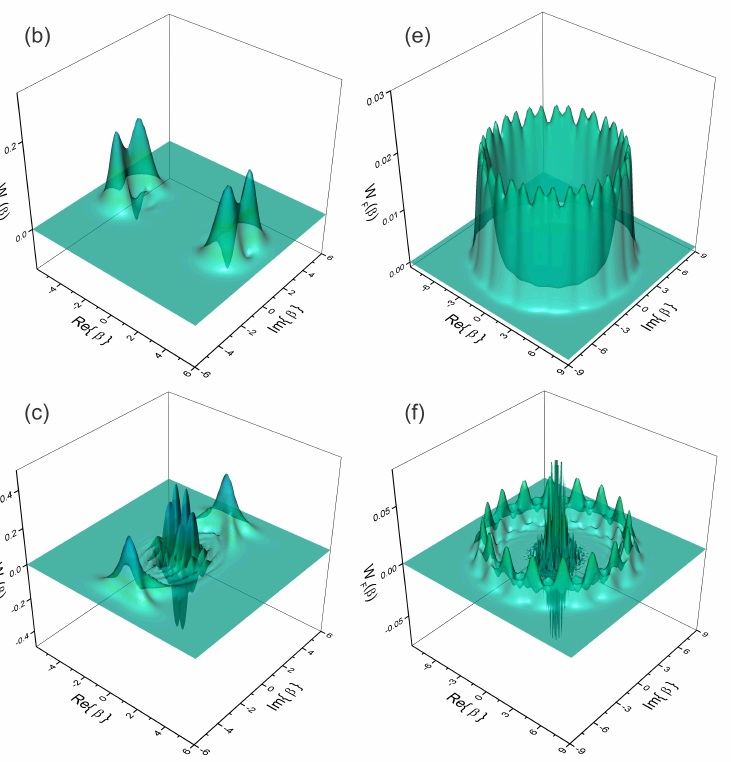
Figure 4. Field Wigner function for Kaleidoscope-State for several values of the time λ t and n . For n = 2 ( a ) λ t = 0, ( b ) λ t ≈ 2.0 and ( c ) λ t ≈ 12.5. And for n = 16 ( d ) λ t = 0, ( e ) λ t ≈ 1.15 and ( f ) λ t ≈